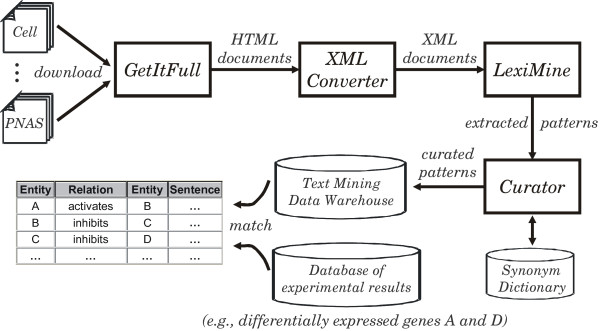
Schematic diagram of the text mining analysis pipeline. Full-text articles are downloaded and processed using the download agent GetItRight. The resulting HTML files are converted to XML. Biological entities (genes, proteins) and their relationships (activation, inhibition, etc.) are extracted from LexiQuest Mine (SPSS, Chicago, IL). The resulting patterns are stored in the text mining data warehouse. The text mining data is matched with results from a differential gene expression experiment.